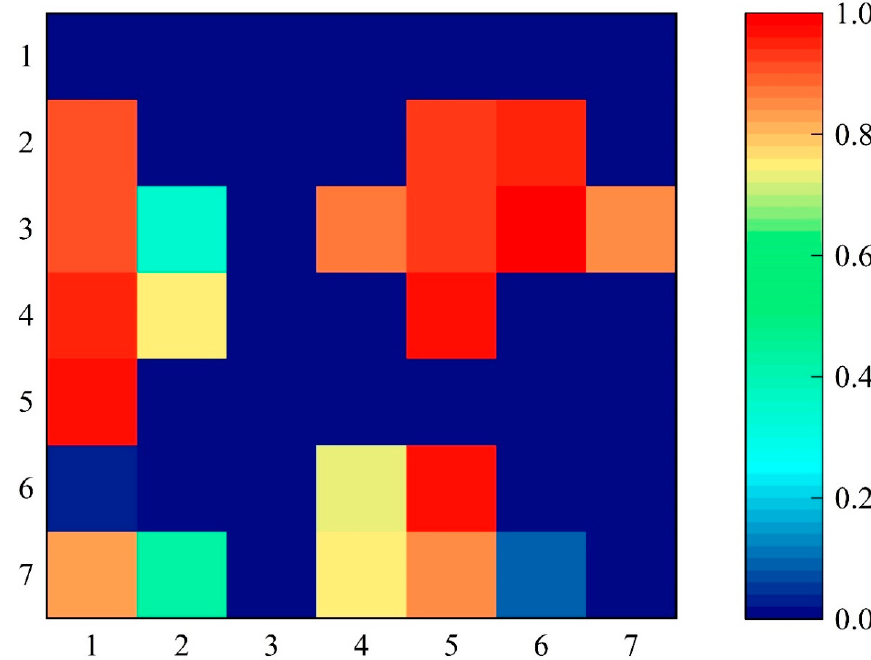
Figure 5. Pairwise control relationships between each compartment in the virtual water system of Tibet. (Note: The control/dependence relationships between each compartment are shown from the matrix column to the matrix row. Compartment number 1: agriculture; 2: mining; 3: manufacturing; 4: energy supply; 5: water supply; 6: construction; 7: services and transport).